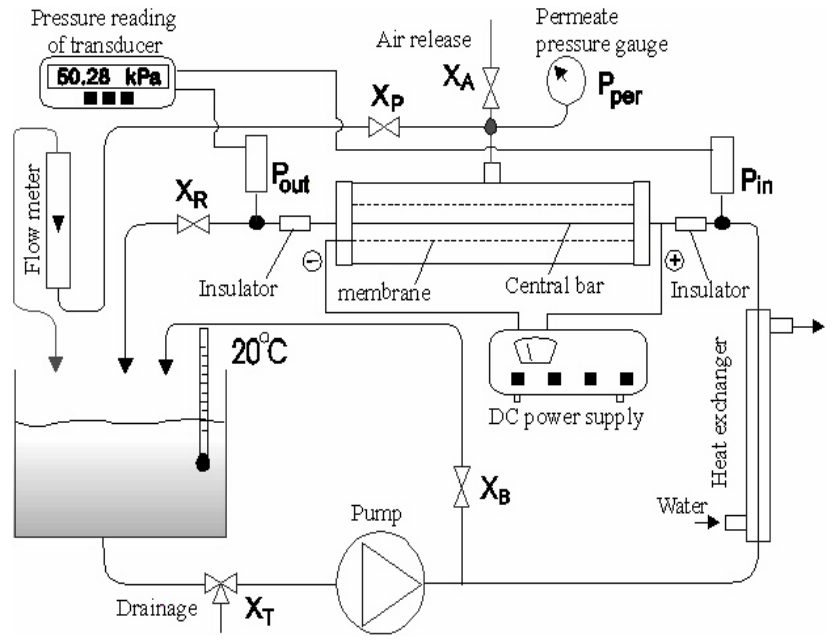
Figure 1. Schematic diagram of the system